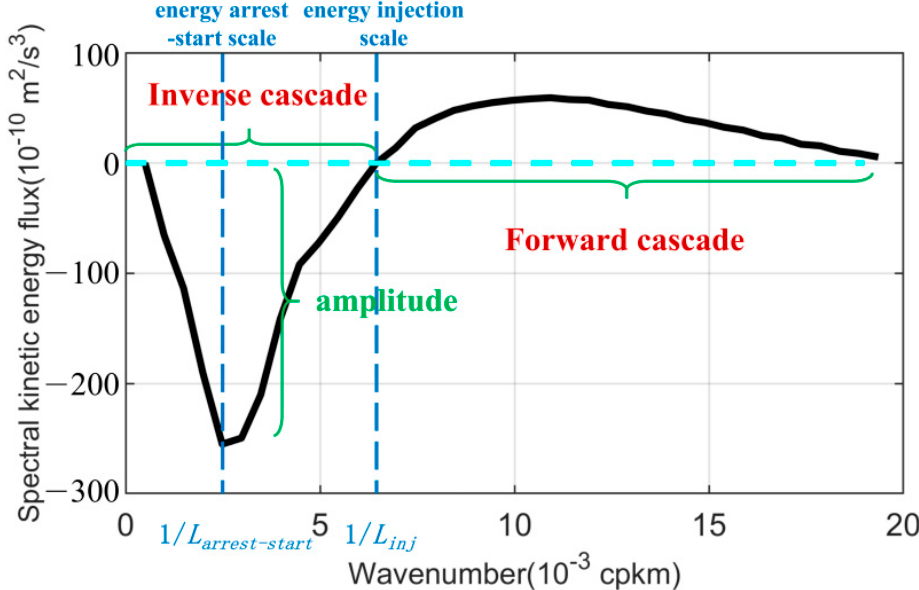
Figure 4. Energy injection scale and energy arrest-start scale. Positive and negative spectral flux indi- cate forward and inverse cascades, respectively. The energy injection scale L inj marks the crossing of inverse to forward cascade, the maximum negative flux marks the energy arrest-start scale L arrest-start . This maximum negative value is defined as the amplitude of inverse kinetic-energy cascade. Black curve just serves as an example ( Π A , from Figure